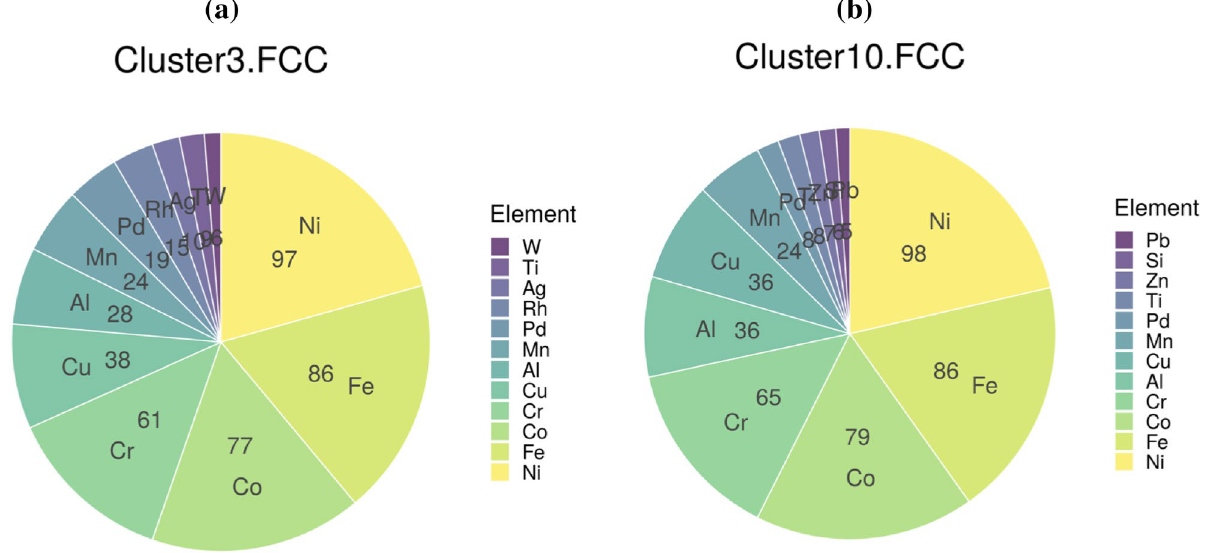
Figure 8. Pie chart showing the distribution of elements in the FCC clusters based on ( a ) BD and ( b ) SHAP decomposition.